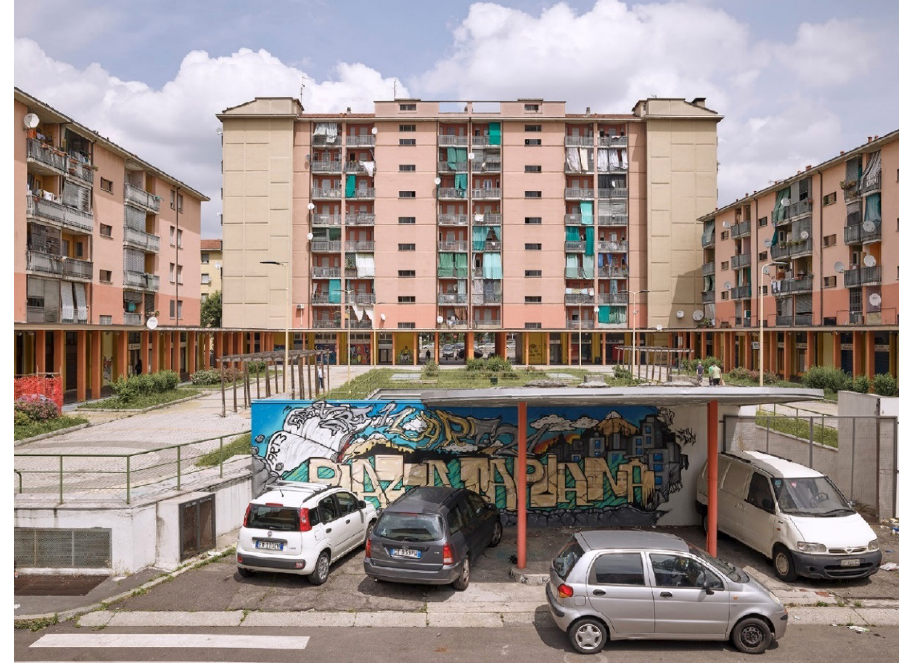
Figure 4. The square of WeMi Capuana. Source: Courtesy of Giovanni